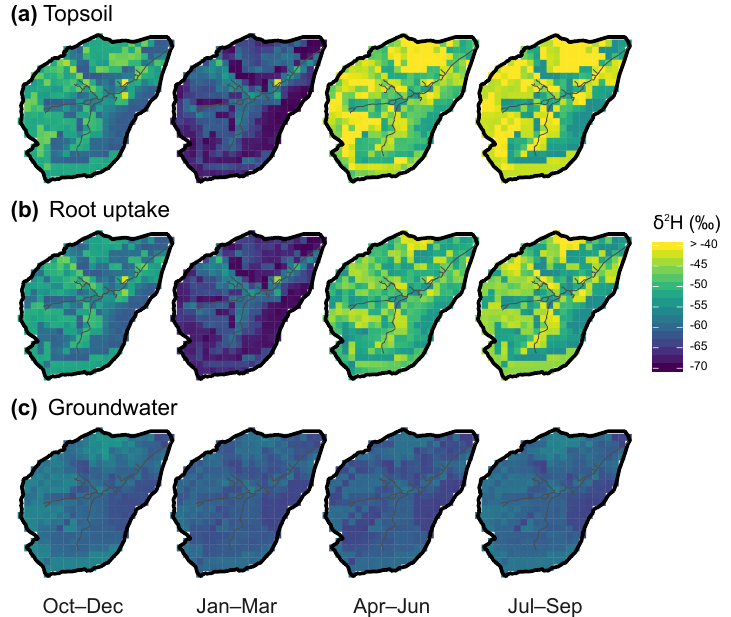
Figure 10. Seasonal average of δ 2 H in the Bruntland Burn over the period 2013–2016, showing the ensemble median of simulations in